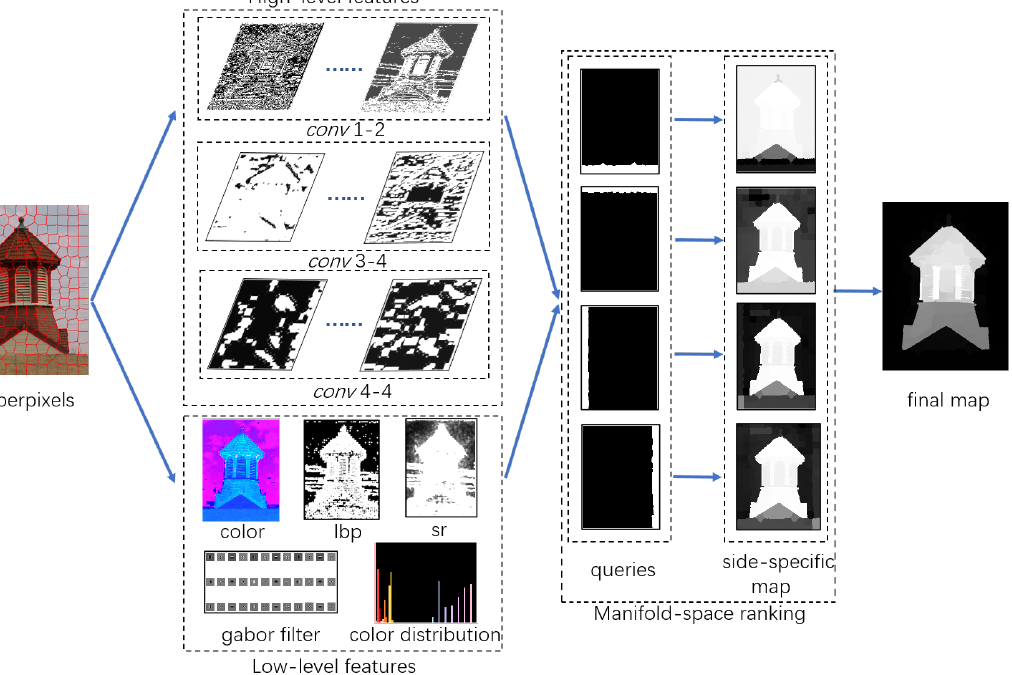
Figure 2. Overall pipeline of our method, including feature extraction, manifold space ranking, and the final saliency